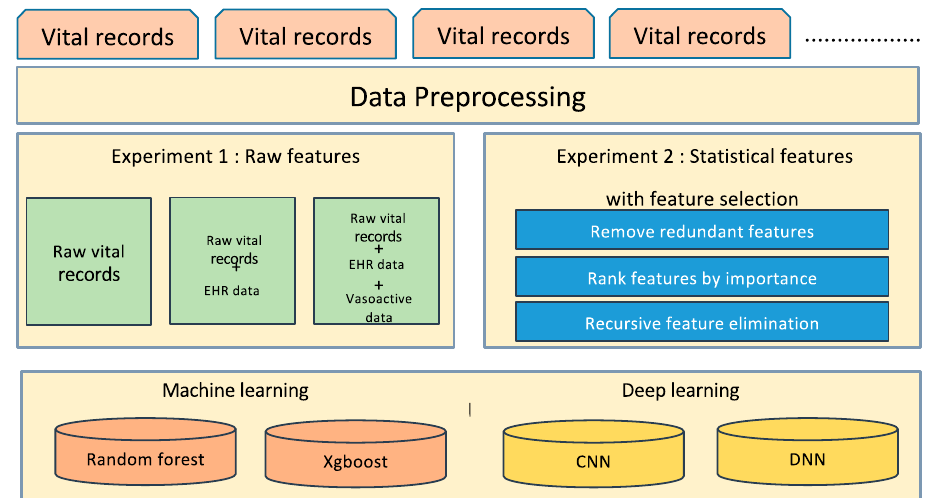
Figure 3. Research framework of hypotension prediction composed of the deep learning model and the machine learning model, using raw features and statistical features.